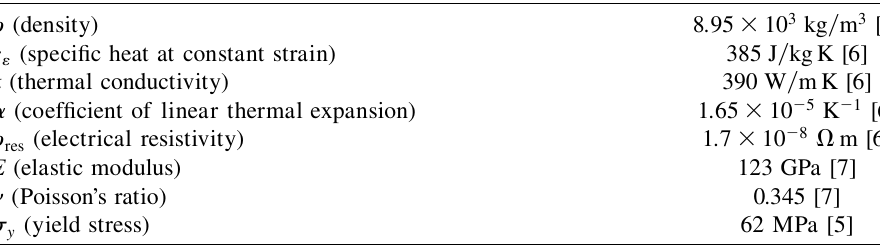
TABLE I. Parameters of fully annealed OFE copper at room